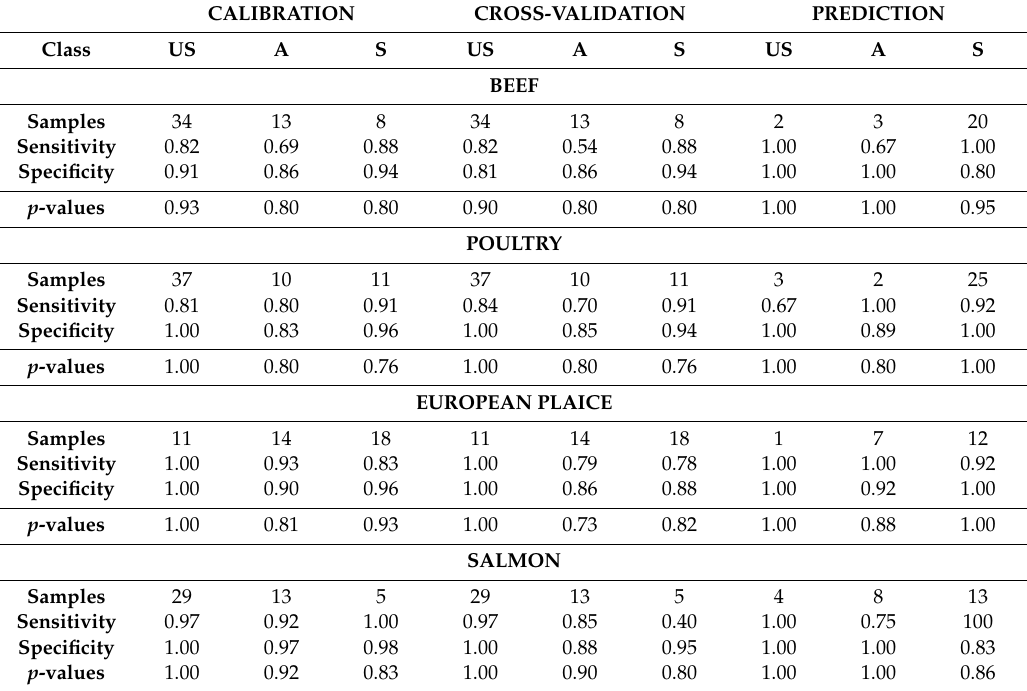
Table 8. ROC curves were used to assess and optimise the specificity and sensitivity of each class with di ff erent thresholds, being 0.41, 0.34, 0.44, and 0.32 for beef, poultry, plaice, and salmon, respectively. Table 8. Results of PLS-DA models developed for the e-nose data collected for beef, poultry, European plaice, and salmon. Sensitivity, specificity percentage, and p-values obtained for each class (Unspoiled, US; Acceptable, A; Spoiled, SP) in calibration, cross-validation, and prediction of the external test set. CALIBRATION CROSS-VALIDATION